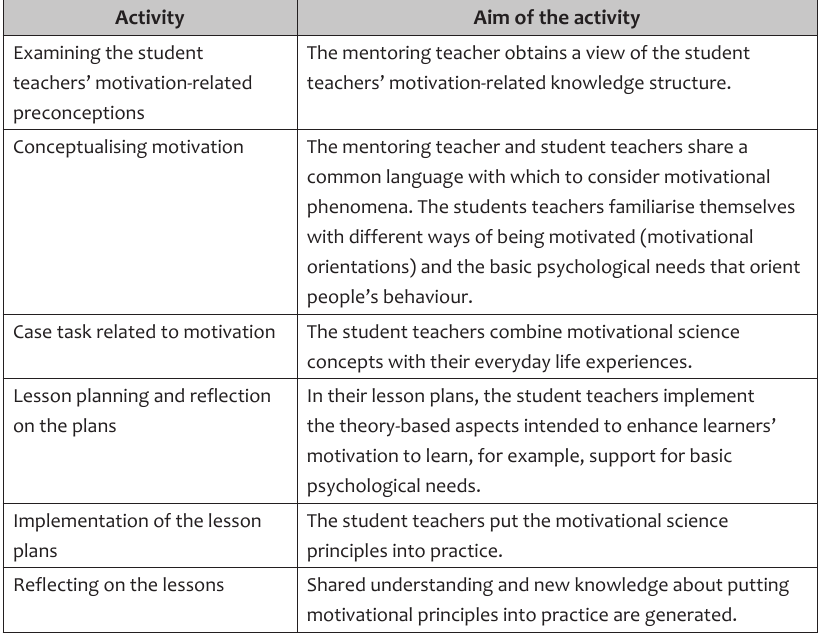
Table 1: Activities in the mentoring procedure